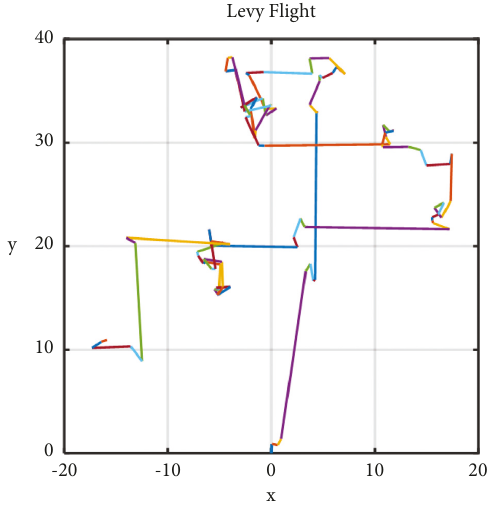
Figure 3: L ´ evy flight trajectory of the generation